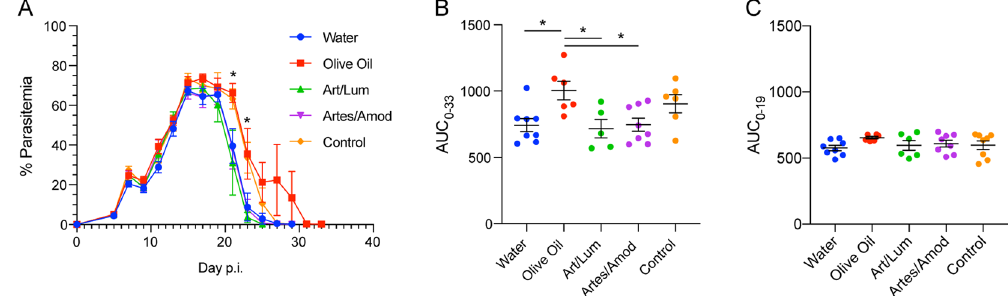
Figure 4. Antimalarial drug treatments do not change susceptibility to Py infection. Mice were treated with antimalarials followed by Py infection at 21 days p.t. ( A) Percent parasitemia on the indicated day post infection (p.i.). ( B) Area under the parasitemia curve (AUC) quantifying overall parasite burden (day 0–33 p.i.) during Py infection for each treatment group. ( C) AUC quantifying parasite burden through peak infection (day 0–19 p.i.) for each treatment group. ( A–C) Data (mean ± S.E.) are the cumulative results of 2 experiments (4 mice/group/